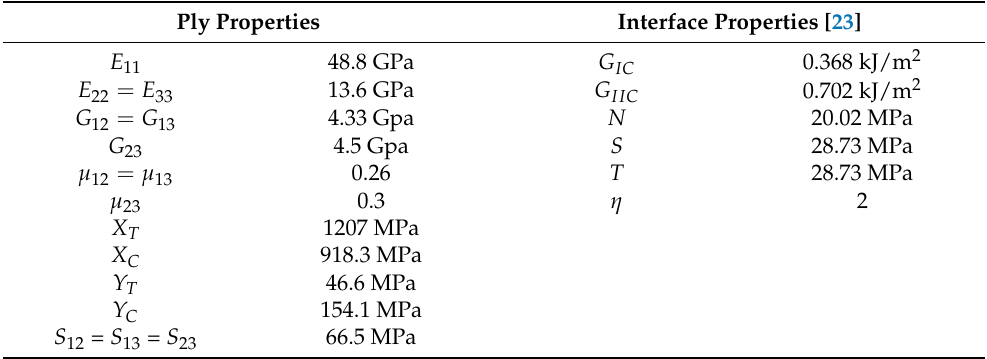
Figure 8. Flow chart of the finite element analysis. Table 4. Material properties of the laminate. Young’s modulus ( E ), shear modulus ( G ), Poisson’s ratio ( µ ), fiber longitudinal strength ( X ), fiber transverse direction strength ( Y ), fiber shear strength ( S ), critical energy release rate ( G C ), interlaminar normal strength ( N ), interlaminar shear strength ( T ), mixed-mode exponent ( η